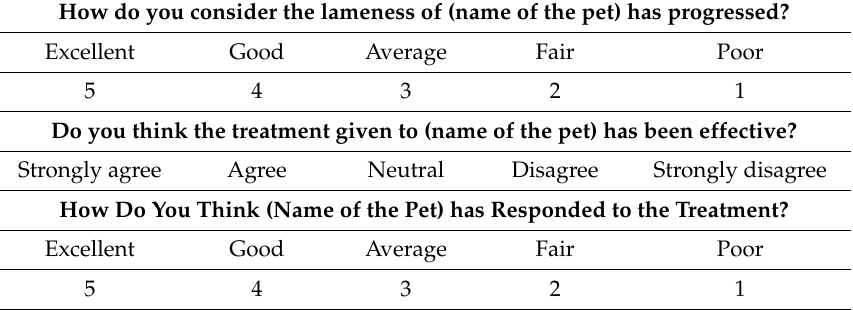
Table 3. Likert-type questionnaire of satisfaction for dog owners at time of implant